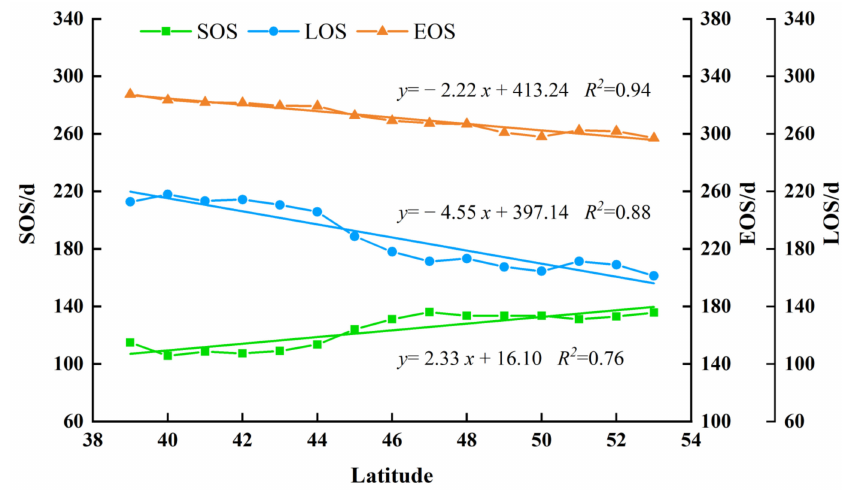
Figure 9. The trends of phenological parameters in northeast China from 2011 to 2020.